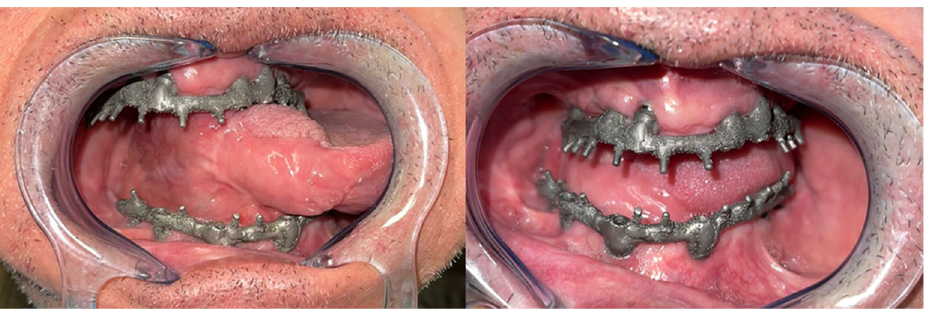
Figure 8. Metal framework evaluated intraorally for functional rehabilitation with a fixed implant-supported prosthesis. FAMM flap for right tongue and floor of the mouth reconstruction.